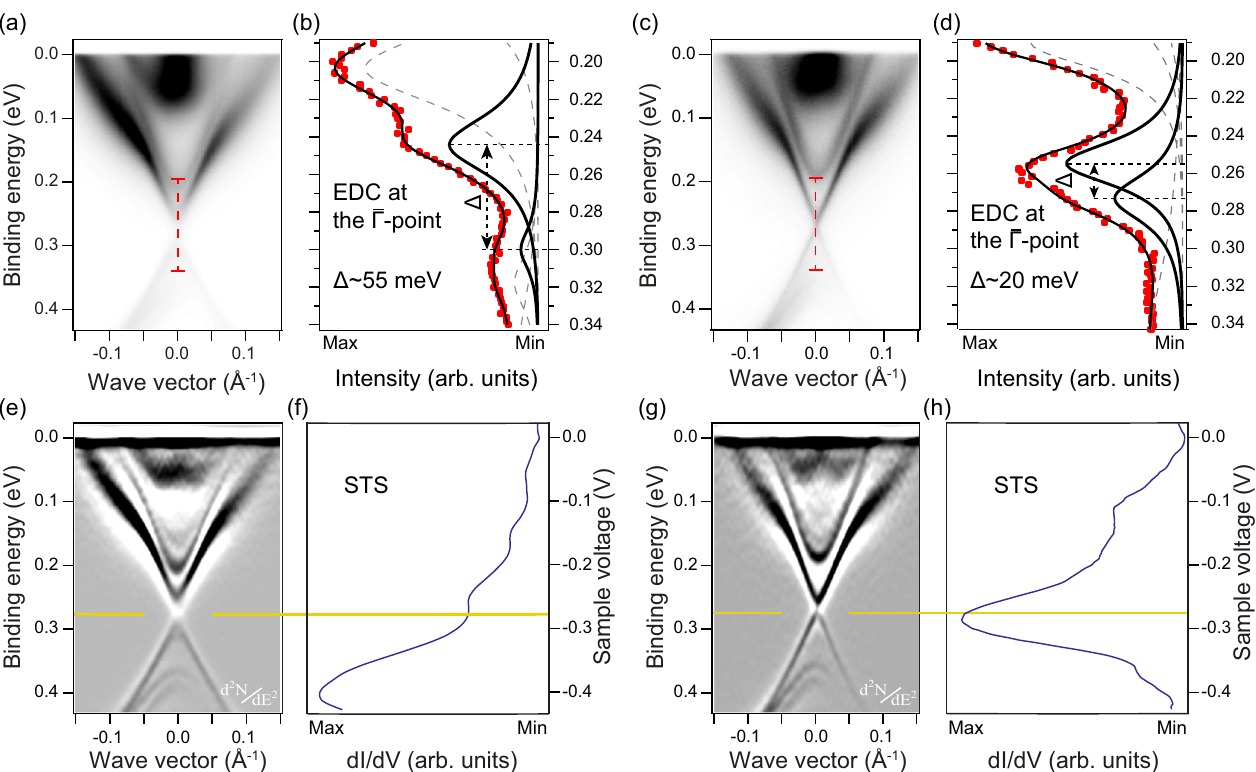
Fig. 4 Comparison of the ARPES and STS data for different Dirac point gaps. a , c Measured MnBi 2 Te 4 (0001) ARPES dispersions corresponding to a larger ( a ) and smaller ( c ) DP gaps (measurements conditions: photon energy h ν = 6.3 eV; temperature T = 10 K). (b,d) Measured (red points) and fi tted (solid black curves) Γ -point EDCs acquired at binding energies close to the gapped DP with decomposition on the spectral components shown. The peaks corresponding to the upper and lower Dirac cone parts are shown by the bold solid black lines, while those of the bulk conduction band -- by the thin dashed gray lines. The binding energy intervals of the presented EDCs correspond to the intervals marked in ( a , c ) by vertical red lines. EDCs fi tting yields the DP gap values of Δ ~55 meV ( b ) and Δ ~20 meV ( d ). e , g Second- derivative (d 2 N /d E 2 ) representation of the data shown in ( a , c ), respectively, providing better visualization of the larger ( e ) and smaller ( g ) DP gaps. ( f , h ) Spatially averaged tunneling conductance spectra showing a clear dip ( f ) and peak ( h ) at the expected energy position of the gapped DP. The spectra shown in ( f , h ) are compatible with larger (~50 meV) and smaller (<20 meV) DP gaps, respectively. The horizontal yellow lines show the correspondence between the ARPES and STS spectra. The d I /d V curves in ( f , h ) are shown in a wider bias voltage range in Supplementary Figs. 4, 5, respectively. The ARPES data in ( a ) and ( c ) correspond to two different samples, while the STS data in ( f ) and ( g ) have been acquired from yet another sample, but after different